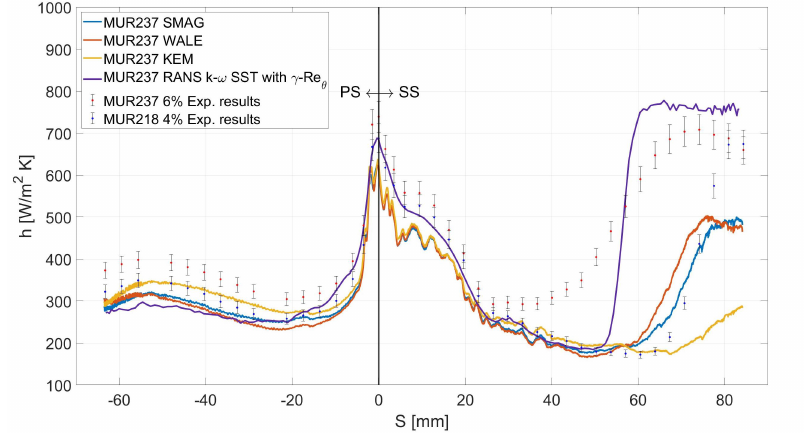
Figure 2. Influence of the SGS closure models: convective heat transfer coefficient.